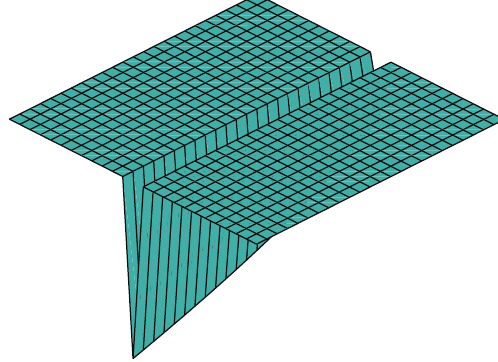
Figure 1: Plot of solution (74) with 𝑐 1 = 1 , 𝑐 2 = 0 .